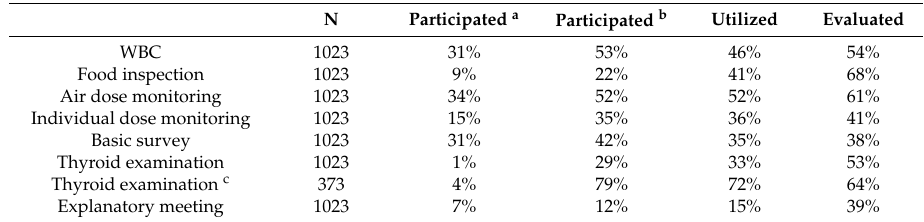
Table 2. Numbers and proportions of those who participated in, utilized, and highly evaluated radiological countermeasures.